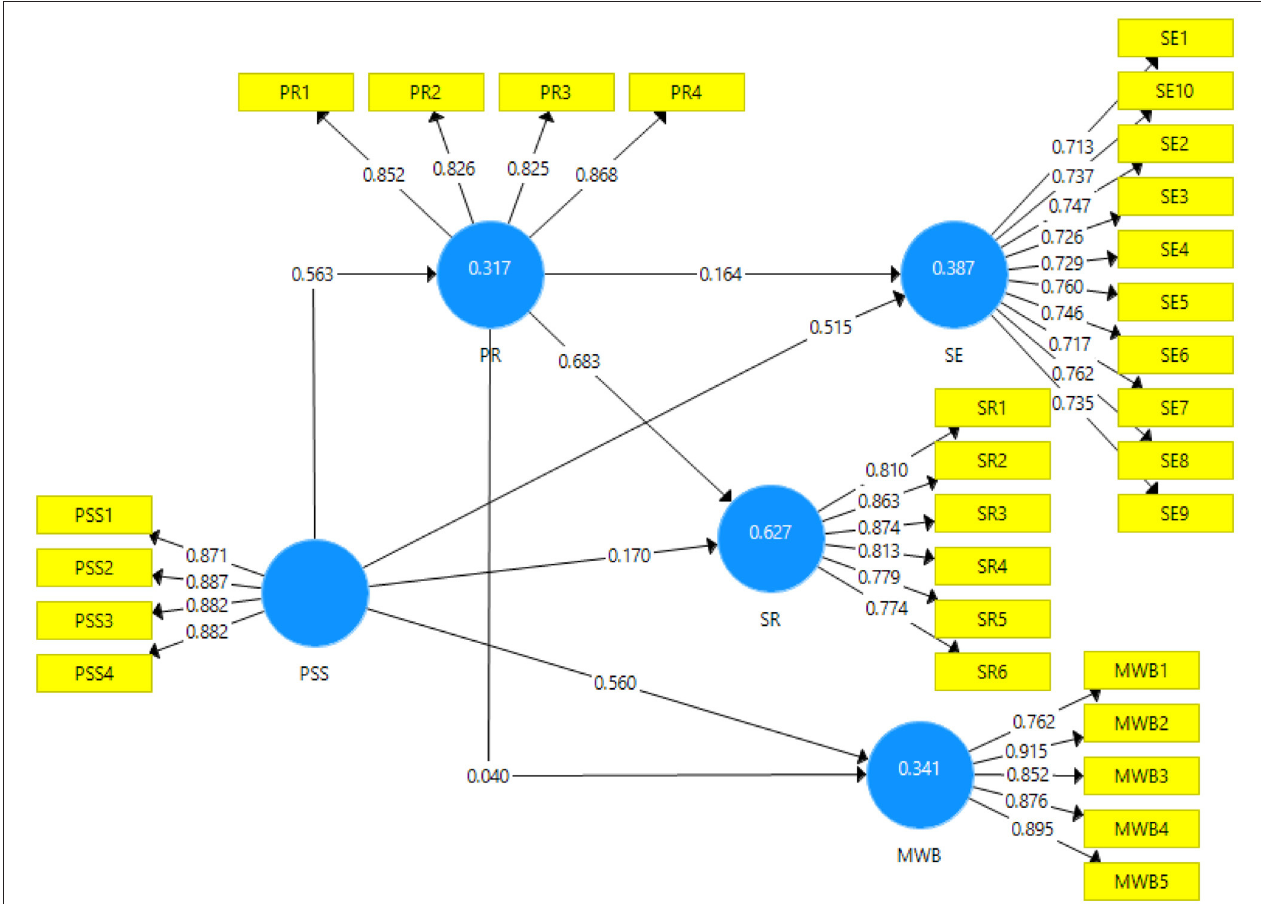
FIGURE 2 | Output of measurement model. PSS, Perceived social support; PR, Psychological resilience; SE, Self-esteem; SR, School readiness; MWB, Mental wellbeing.